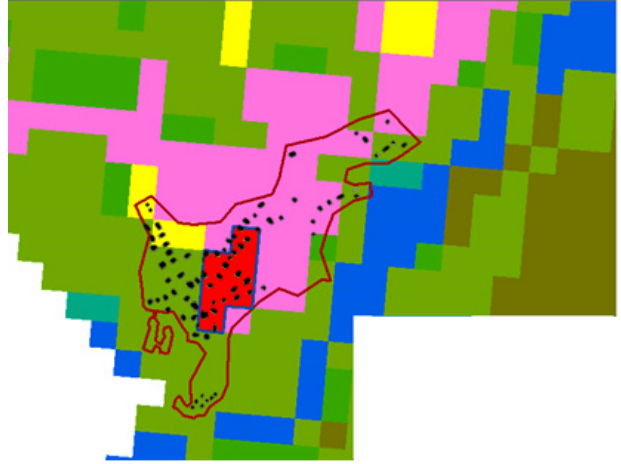
Figure 2. Distribution of buildings within the settlement of Pershlakhta superimposed on the used land-cover map (the red pixels show the built-up land-cover class, red line shows administrative boundary of the settlement, black rectangles show buildings).